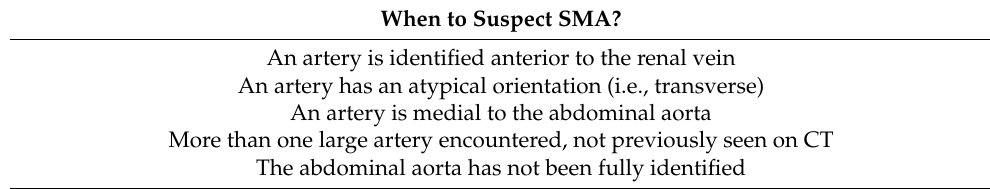
Table 1. When to suspect